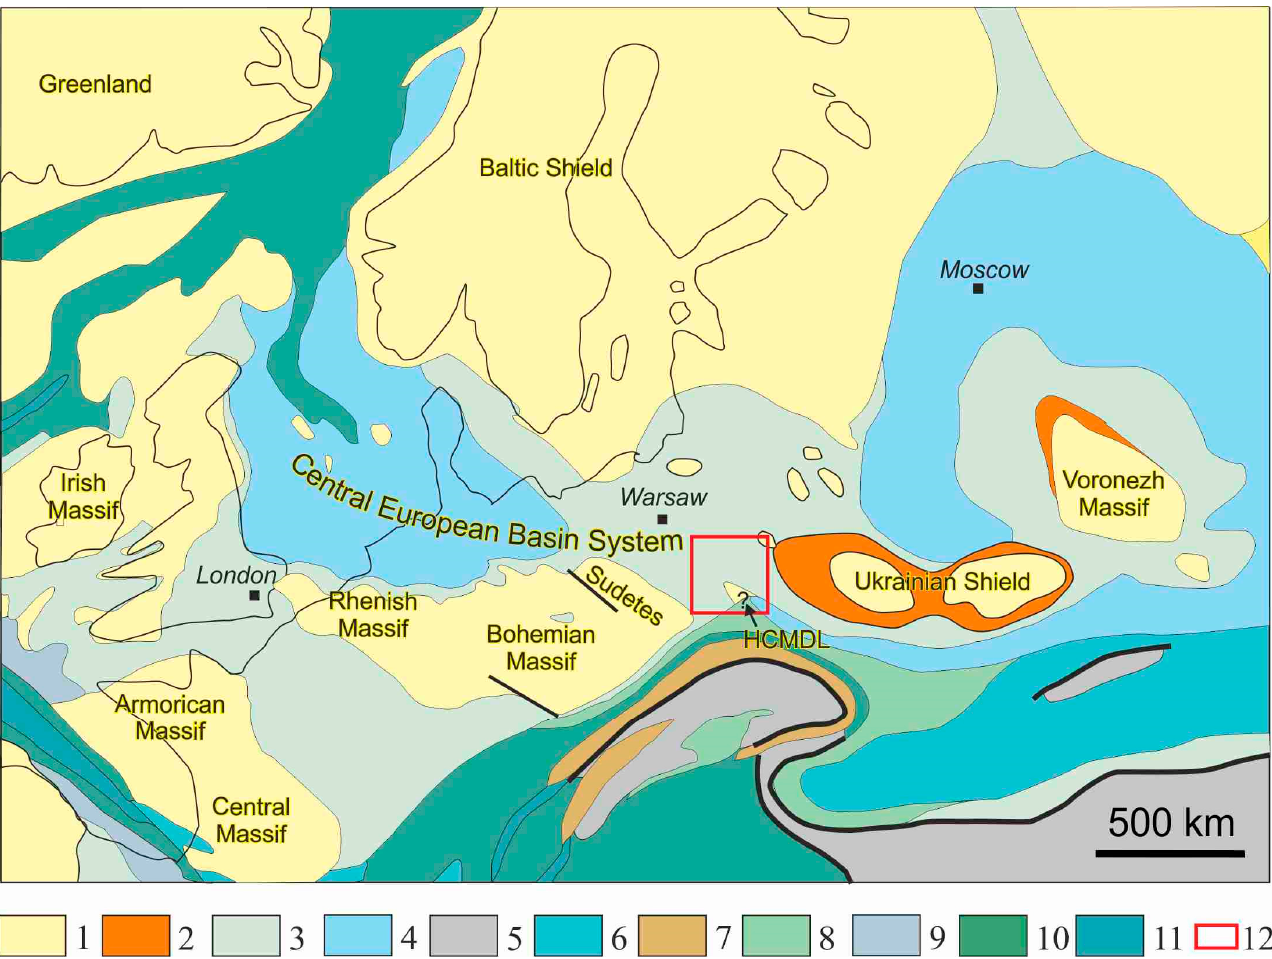
Figure 1. Albian palaeogeography of epicontinental sea and adjacent western Tethys of Europe with simplified distribution of facies (modified from [5,20]); 1—land areas; 2—deltaic, coastal, and shallow marine clastic facies (sands and conglomerates, sands and shales); 3—shallow-marine facies (sands, marls, carbonate marls, marly carbonates, carbonates); 4—mainly shallow-carbonate marine facies (marly carbonates, carbonates, chalk, white chalk, carbonate shales); 5—active fold belts, high relief; 6—marine carbonates; 7—deeper marine clastics (sand and shales); 8—deeper marine carbonates (with sands and shales); 9—carbonates and sands; 10—deeper marine facies (sands and shales, shales); 11—deeper marine shale facies from a rift area; 12—area of the study; HCMDL—hypothetic Holy Cross Mountains—Dobruja Land; ?—no precise data for the southern edge of the HCMDL.